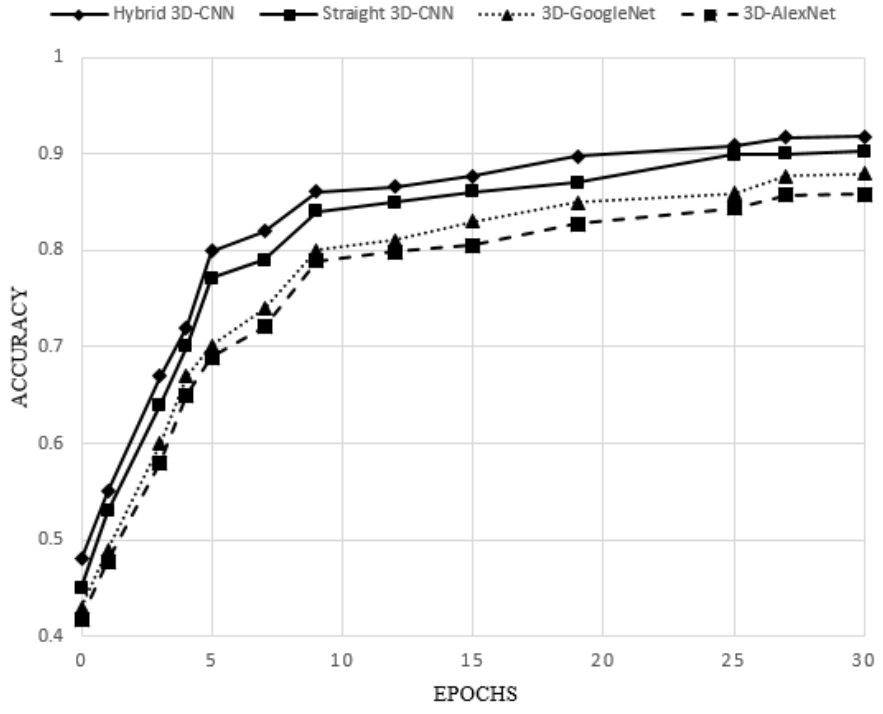
Figure 5. Accuracy of the four 3D-CNN architectures over epochs.